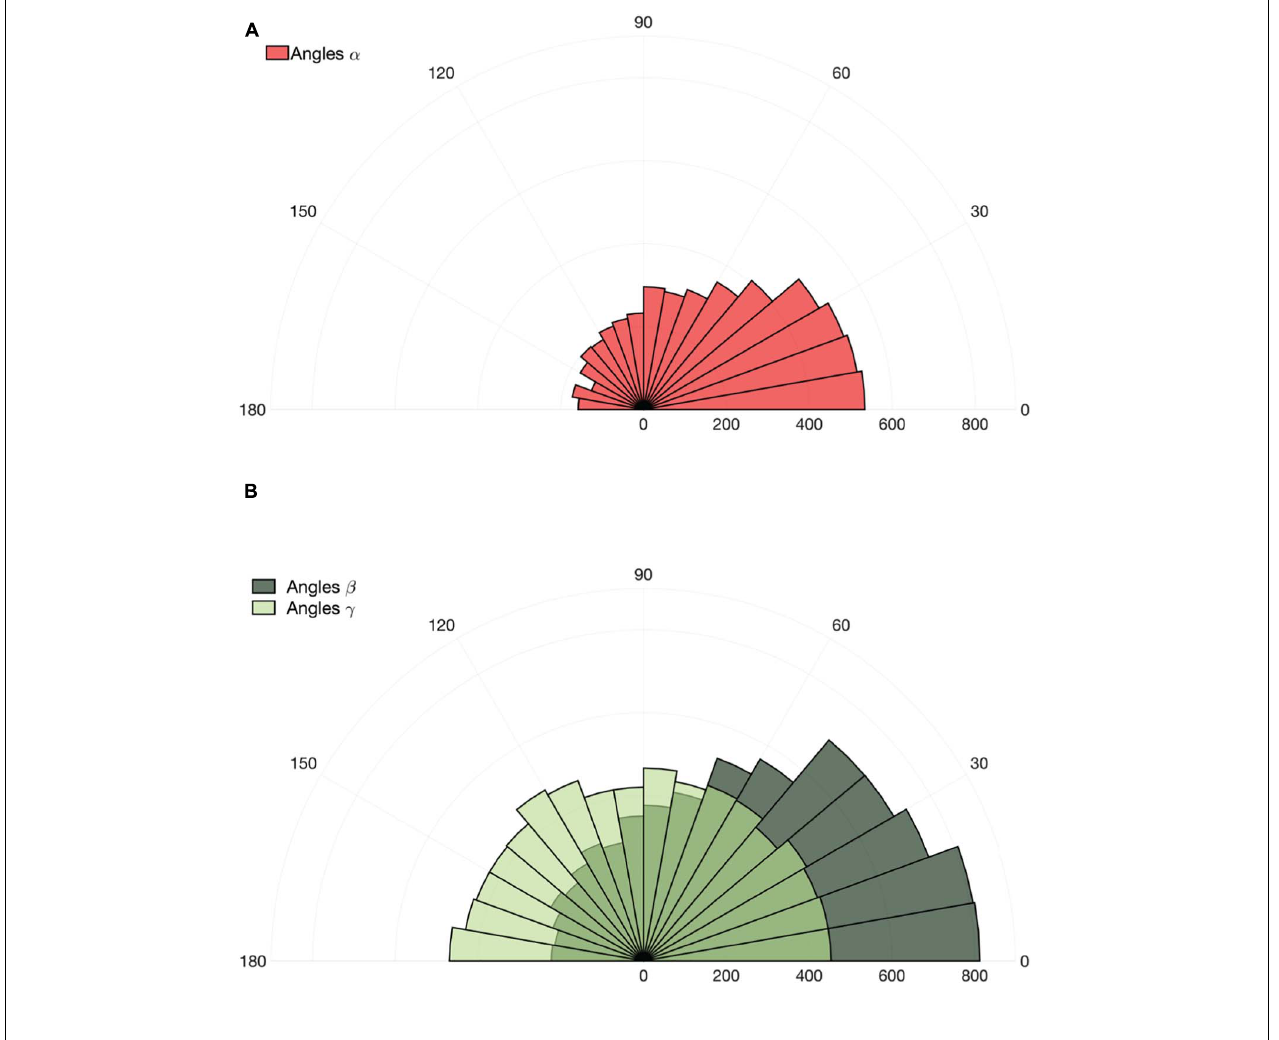
FIGURE 3 | (A) Polar histograms of the angles ( ABR α ) between the OBS and MOD velocity vectors and (B) between the loggerhead turtle (LT) ground velocity and the MOD sea current velocity vectors ( ABR β ; dark green) and between the LT ground velocity and the MOD Tidal current velocity vectors ( ABR γ ; light green).